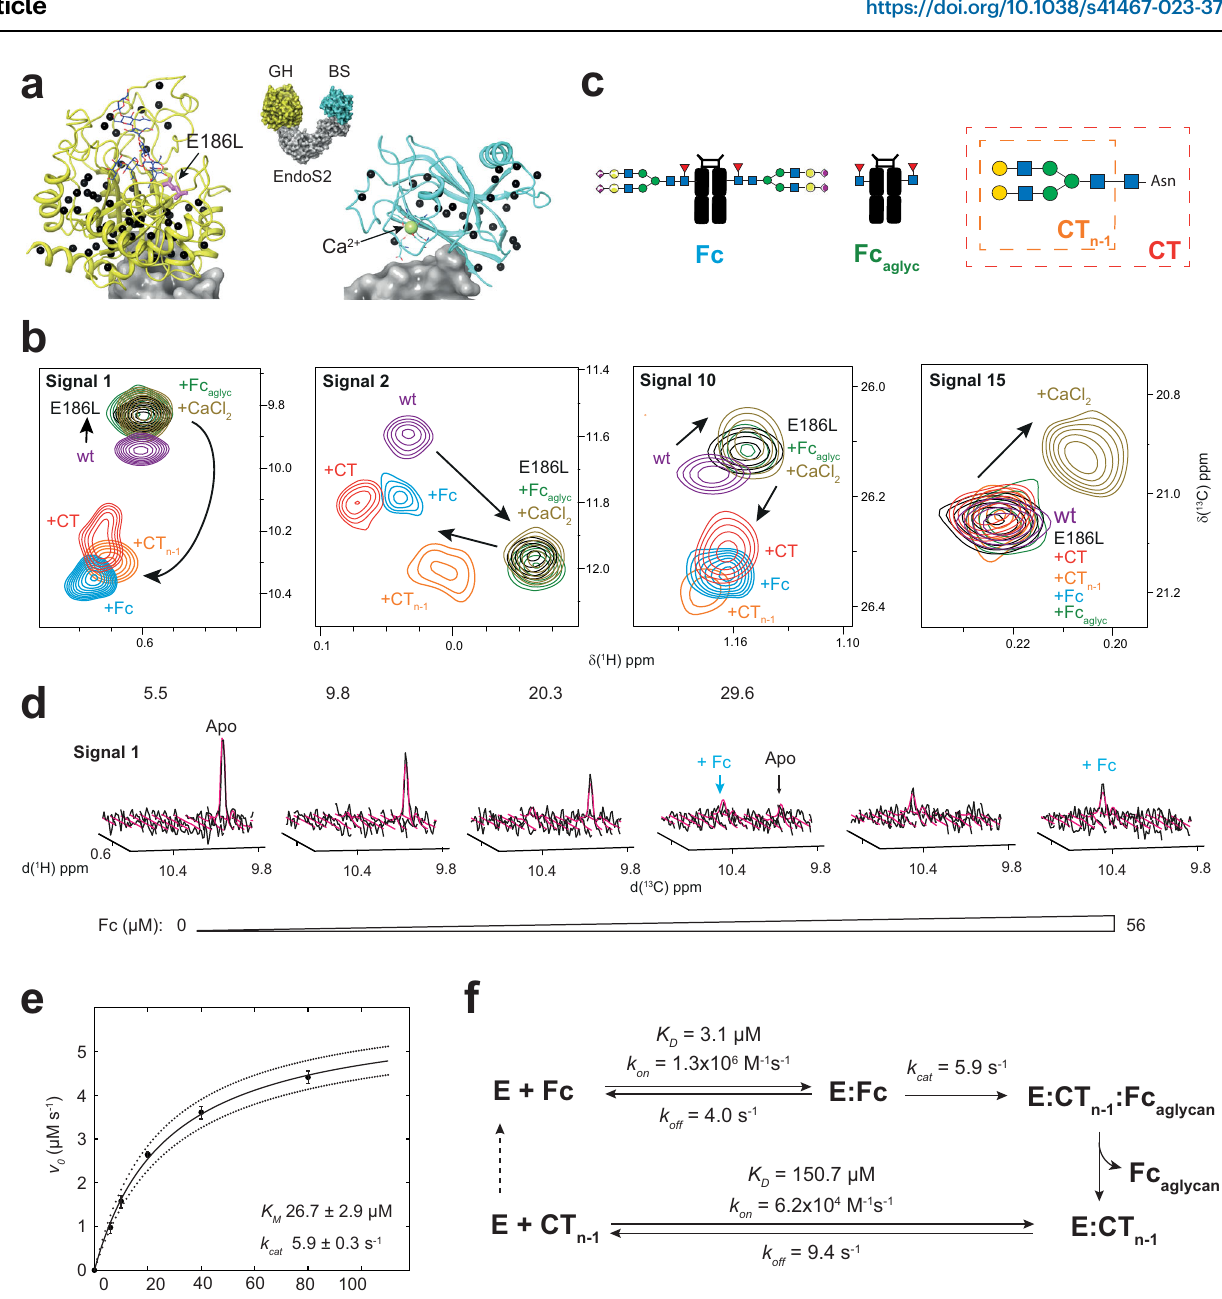
based 2D lineshape fi tting of methyl-TROSY spectra of a representative signal for the titration of EndoS2 E186L with Fc. Experimental and fi tted spectra are shown as black and pink surfaces, respectively. Inserts correspond to 0, 5.5, 9.8, 20.3, 29.6 and 56 µ M Fc concentrations. e [S] 0 -dependence of the initial enzyme cycling velocity.Thesolidlinerepresentsthebest- fi ttoMichaelisMentenEq.4,anddotted linescorrespondtoonestandarddeviation.Dataarepresentedasmean,anderrors correspond to standard deviation. f Schematic mechanism of Fc N -glycan proces- singbyEndoS2asdeterminedfromlineshapeanalysis.Theaf fi nityofEndoS2(here E) for Fc is two orders of magnitude higher as compared to the reaction product CT n − 1 , promoting substrate depletion. On-rates are responsible for increased af fi - nitytowardsFcas compared to CT n − 1 , suggesting differencesinthe initialenzyme- ligand encounterevent.Valuescorrespond to( f )and Table1.Allexperiments were acquired at 600MHz and